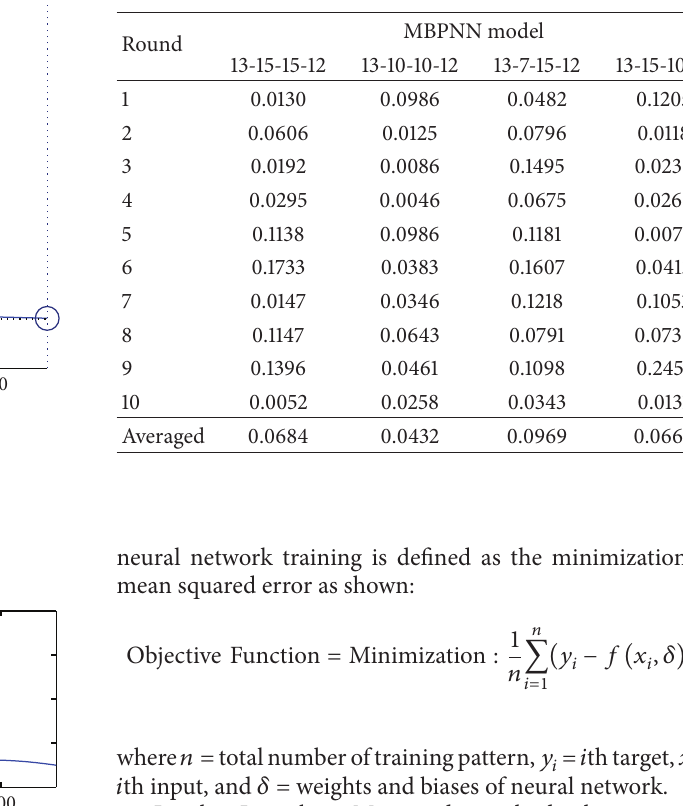
Table 7: RMSE of each MBPNN model from K-fold cross-